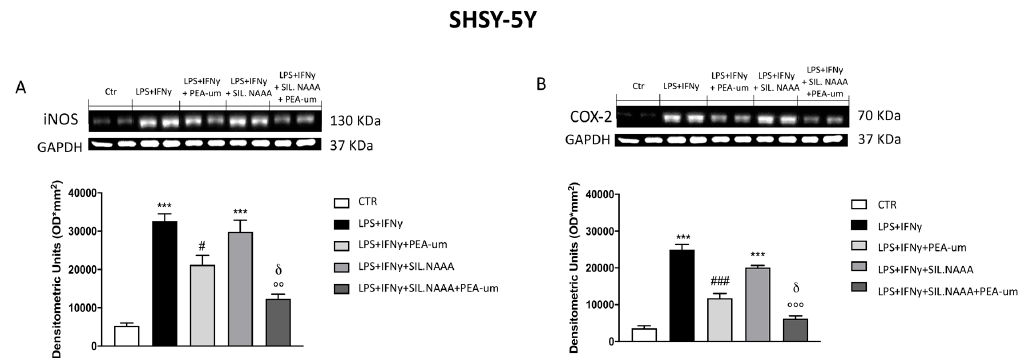
Figure 5. E ff ect of PEA-um treatment and NAAA-siRNA knockdown on the expression of iNOS, and COX-2 in SHSY-5Y human neuroblastoma cells. An increase in iNOS and COX-2 expression